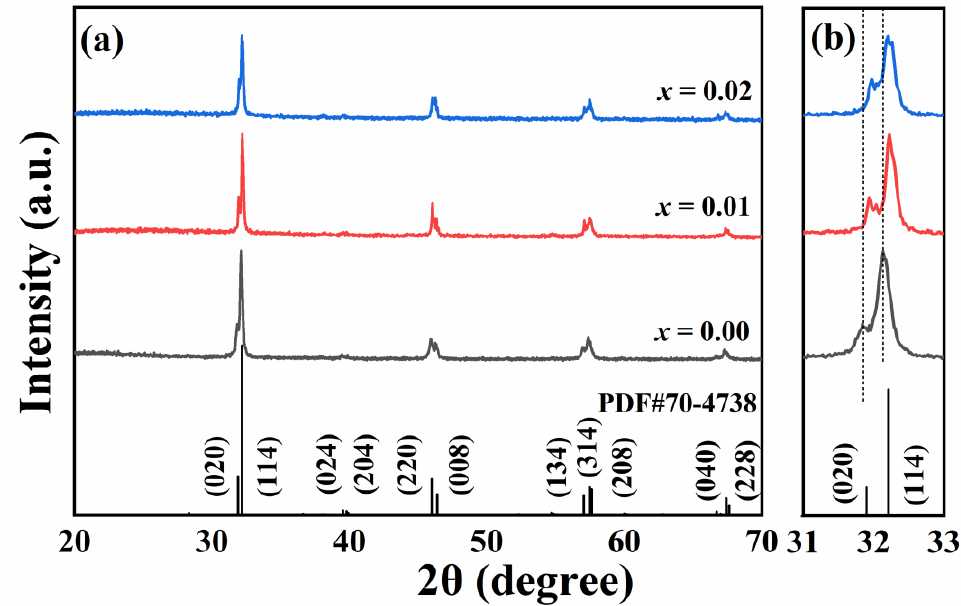
Figure 1. ( a ) XRD patterns, ( b ) the enlarged part of diffraction peaks around 32° of ANCe x ceramics.